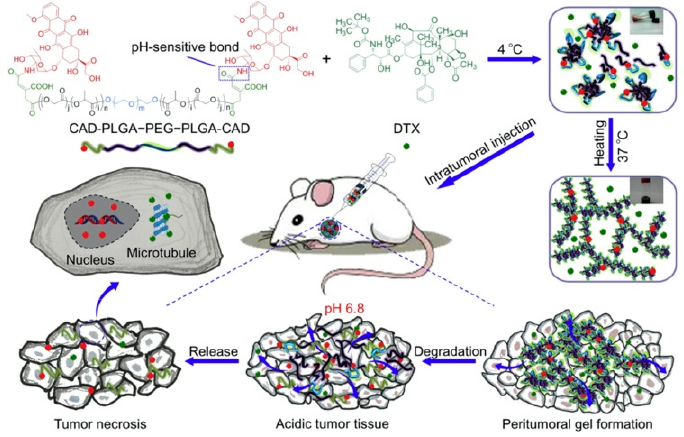
Figure 4. Schematic image of thermoresponsive hydrogels with PLGA–PEG–PLGA–drug conjugate. Reprinted from [37] Acta Biomaterialia, 77, Yanbo Zhang et al., Tumor microenvironment-labile polymer–doxorubicin conjugate thermogel combined with docetaxel for in situ synergistic chemotherapy of hepatoma, 63–73, Copyright (2018), with permission from Elsevier.